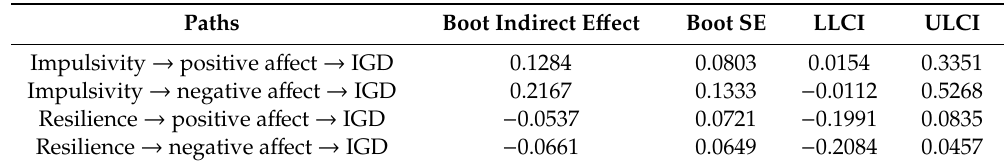
Table 4. Model of mediation analysis of a ff ect status between impulsivity or resilience and severity of IGD symptoms in the HC